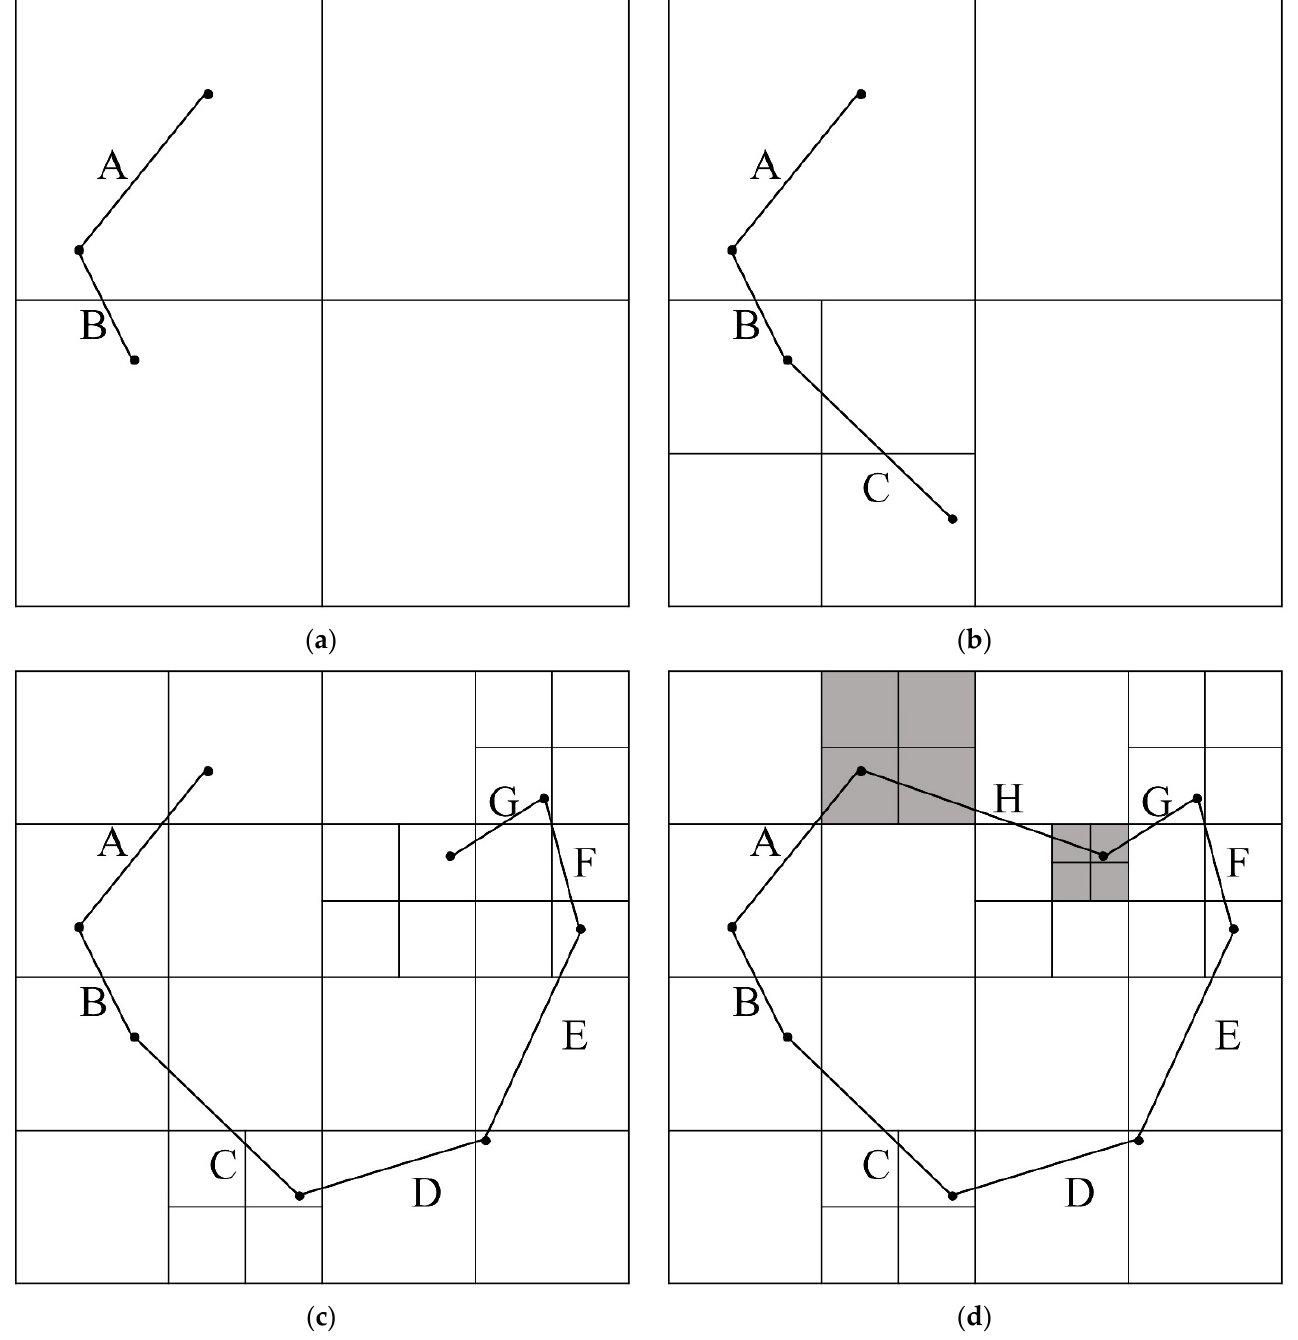
Figure 1. Example of polygon map random (PMR) quadtree generation: ( a ) Quadtree generated by line segment B; ( b ) Quadtree generated by line segment C; ( c ) Quadtree generated by line segment D–G; ( d ) Quadtree generated by line segment H.